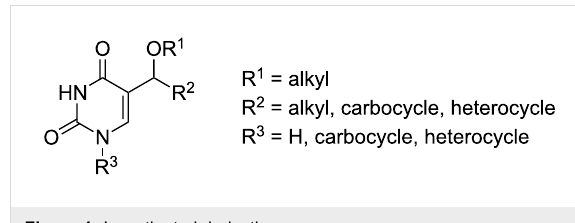
Figure 1: Investigated derivatives.